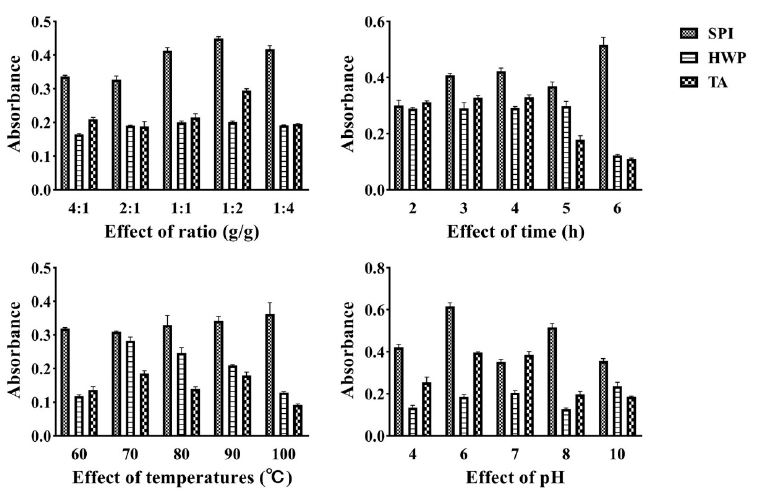
Figure 4. Total antioxidant capacity of the complex under different treatment conditions.